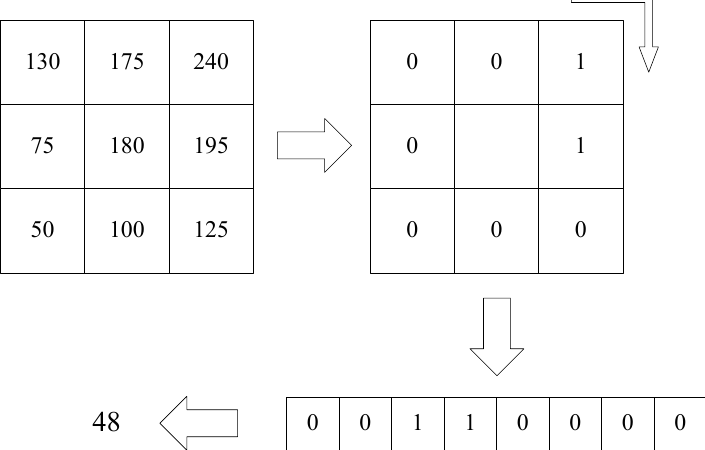
Figure 4. The principle of LBP